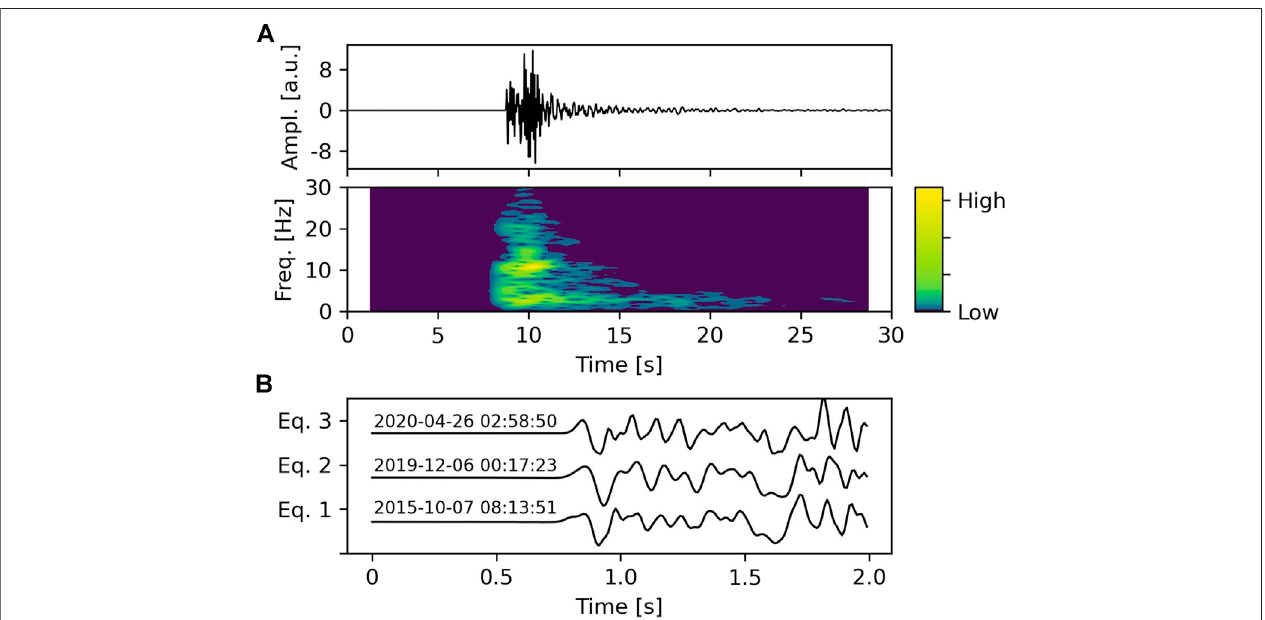
FIGURE 6 | (A) Seismogram and spectrogram of the Md 3.3 earthquake recorded during the April 26, 2020 swarm. (B) The onset of the earthquake (Eq. 3) is comparedwithoneofthemajoreventsoftheswarmoccurredonOctober7,2015(Eq.1Md (cid:1) 2.3)andthestrongesteventoftheDecember6,2019swarm(Eq.2Md (cid:1) 3.1). CAAM station (see Figure 3 ) vertical components are